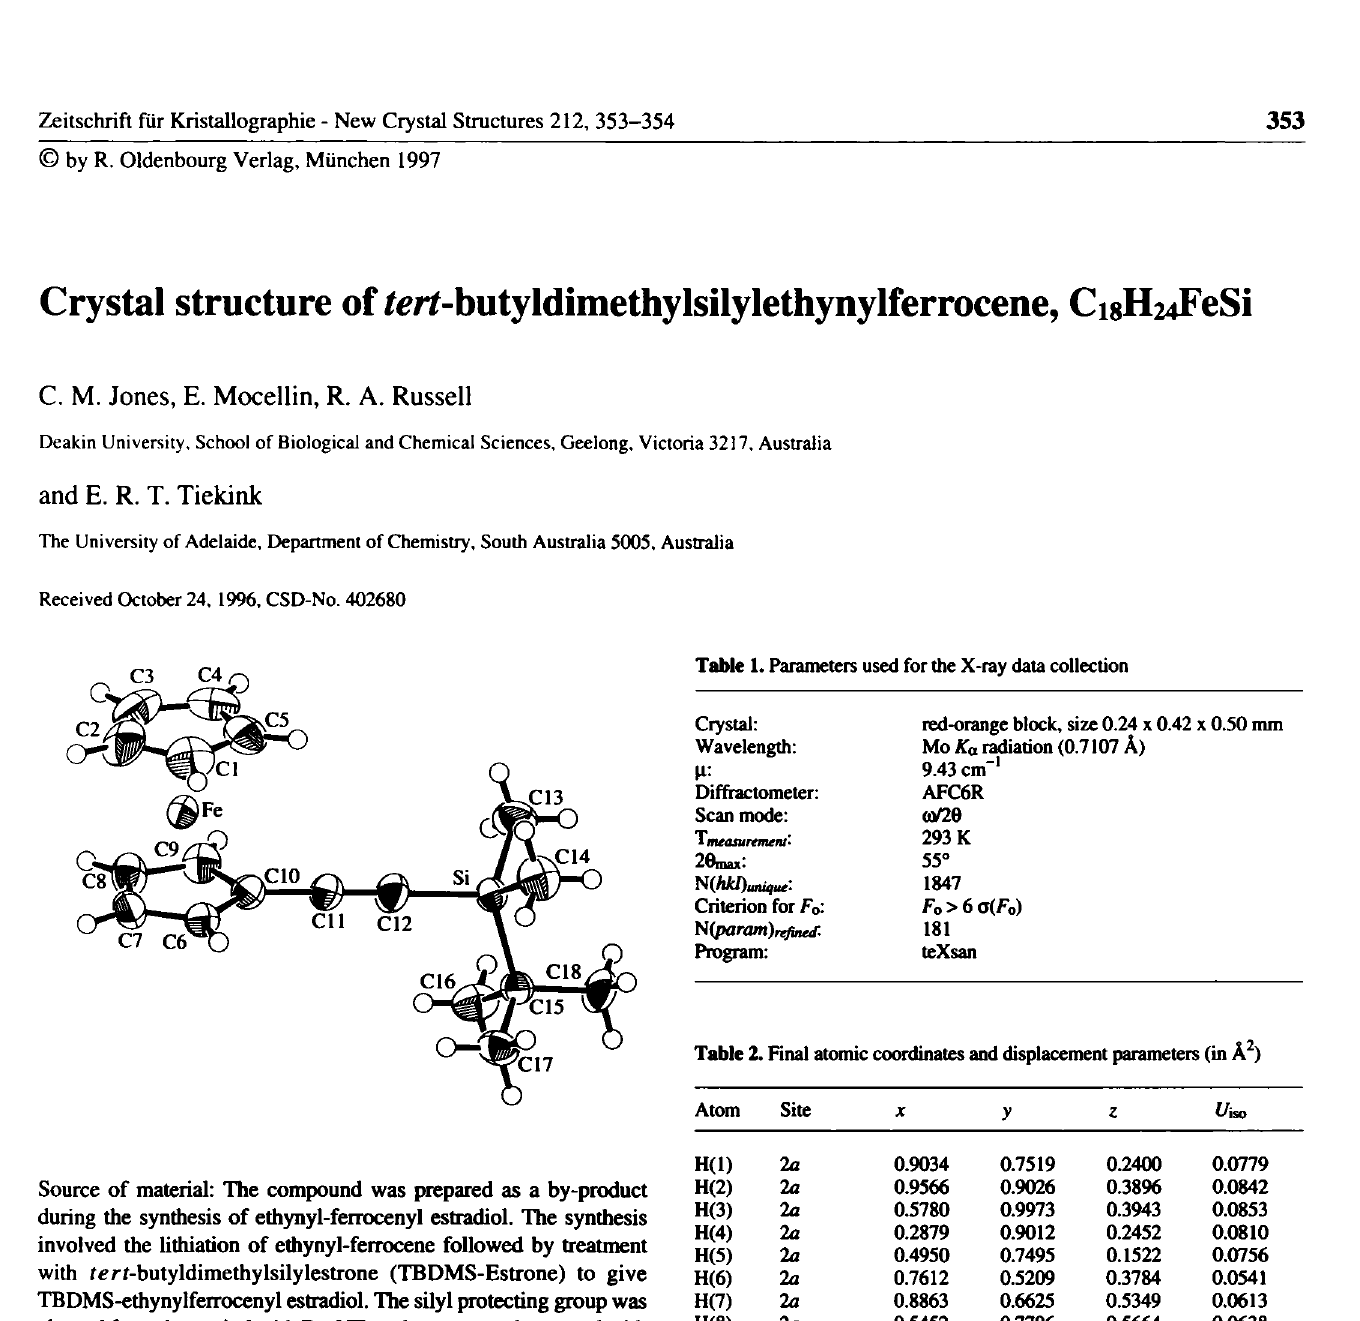
Table 2. Final atomic coordinates and displacement parameters (in Â 2 )